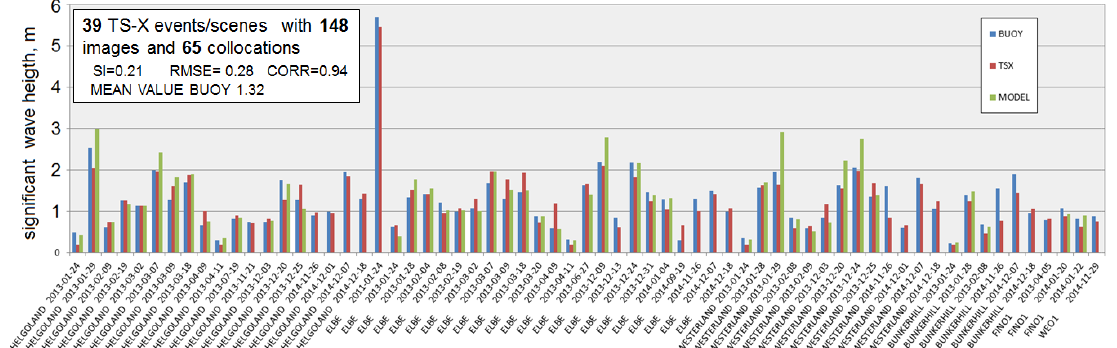
Figure 11. Comparison of total significant wave height H S derived using TerraSAR-X /XWAVE_C algorithm, buoy measurements and collocated CWAM model results for all acquired and collocated TS-X images in German Bight 2013-2014 (65 collocations) including a storm on 09.12.2011. The data are systematized according to measurement station and acquisition time.